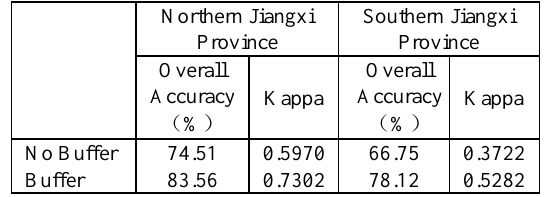
Table 4. The comparison of accuracy assessment criteria of GlobeLand30 and China land use